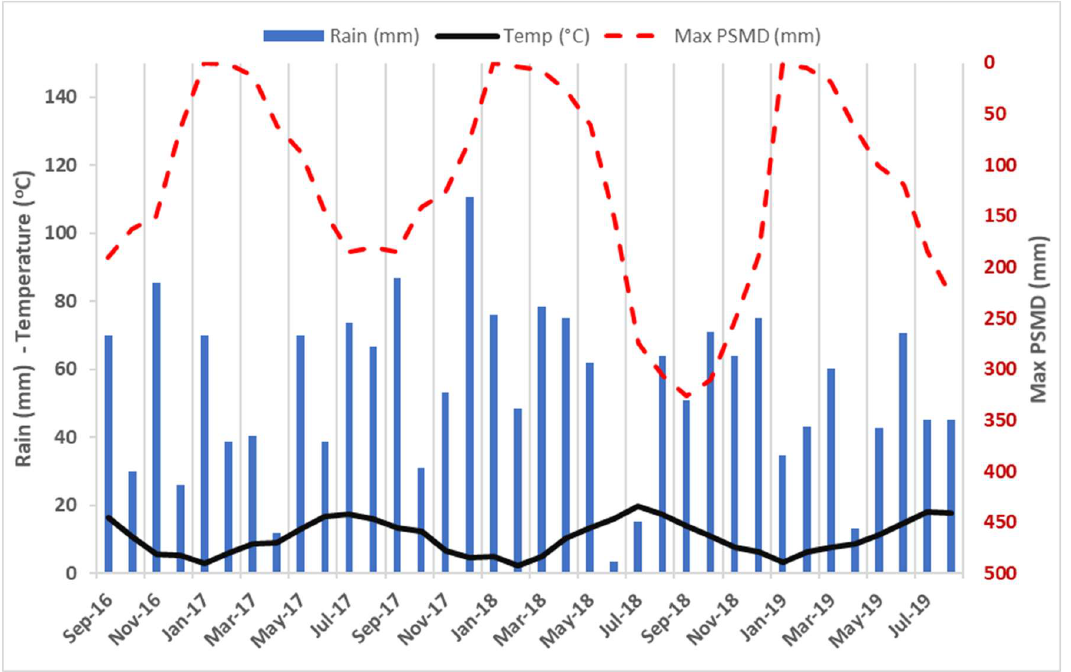
Figure 1. Google Earth image of Rothamsted Research experimental farm (coordinate system EPSG:27700), with wheat field boundaries from 2017, 2018, and 2019 indicated using red lines (see also Table 1).